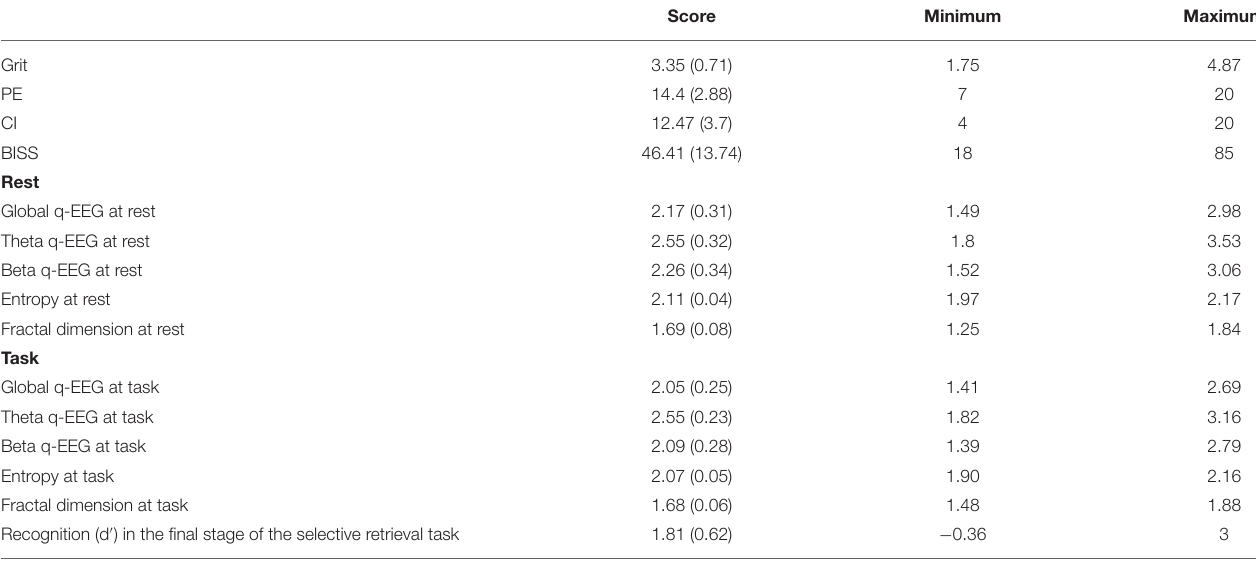
TABLE 1 | Descriptive statistics for the main variables.